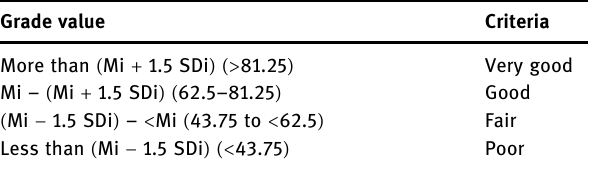
Table 2: Assessment criteria Grade value